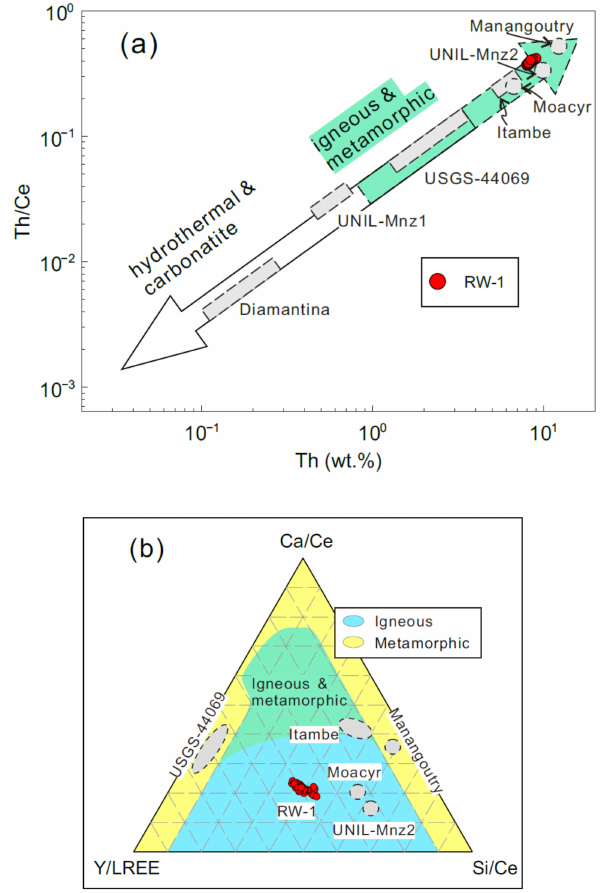
Figure 4. ( a , b ) Discrimination of monazite with di ff erent origins including igneous, metamorphic, hydrothermal, and carbonatite monazite. The integrated data are from the literature (Table S2). The Diamantina, UNIL-Mnz1, USGS-44069, Itambe, Moacyr, UNIL-Mnz2, and Manangoutry data are from Rubatto et al. [14], Didier et al. [15], and Gonçalves et al.